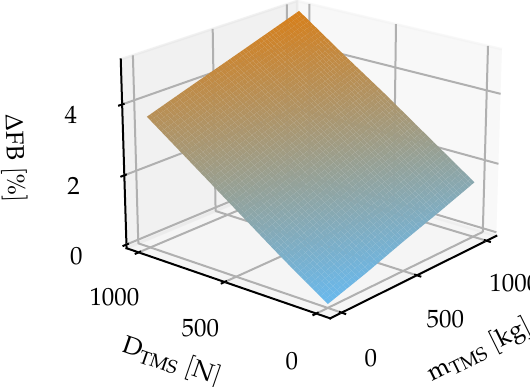
Figure 5. Aircraft FB sensitivity for S P =